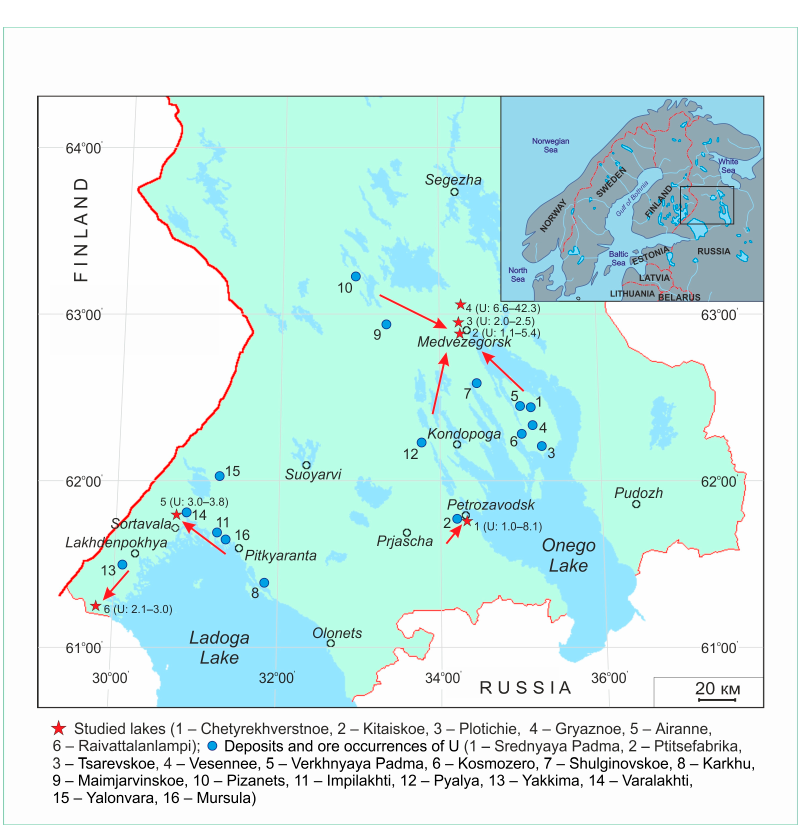
Figure 4. Study area with indication of places of lake sediments with U anomalies (the range of U concentration is indicated in parentheses) and some deposits and ore occurrences of U.